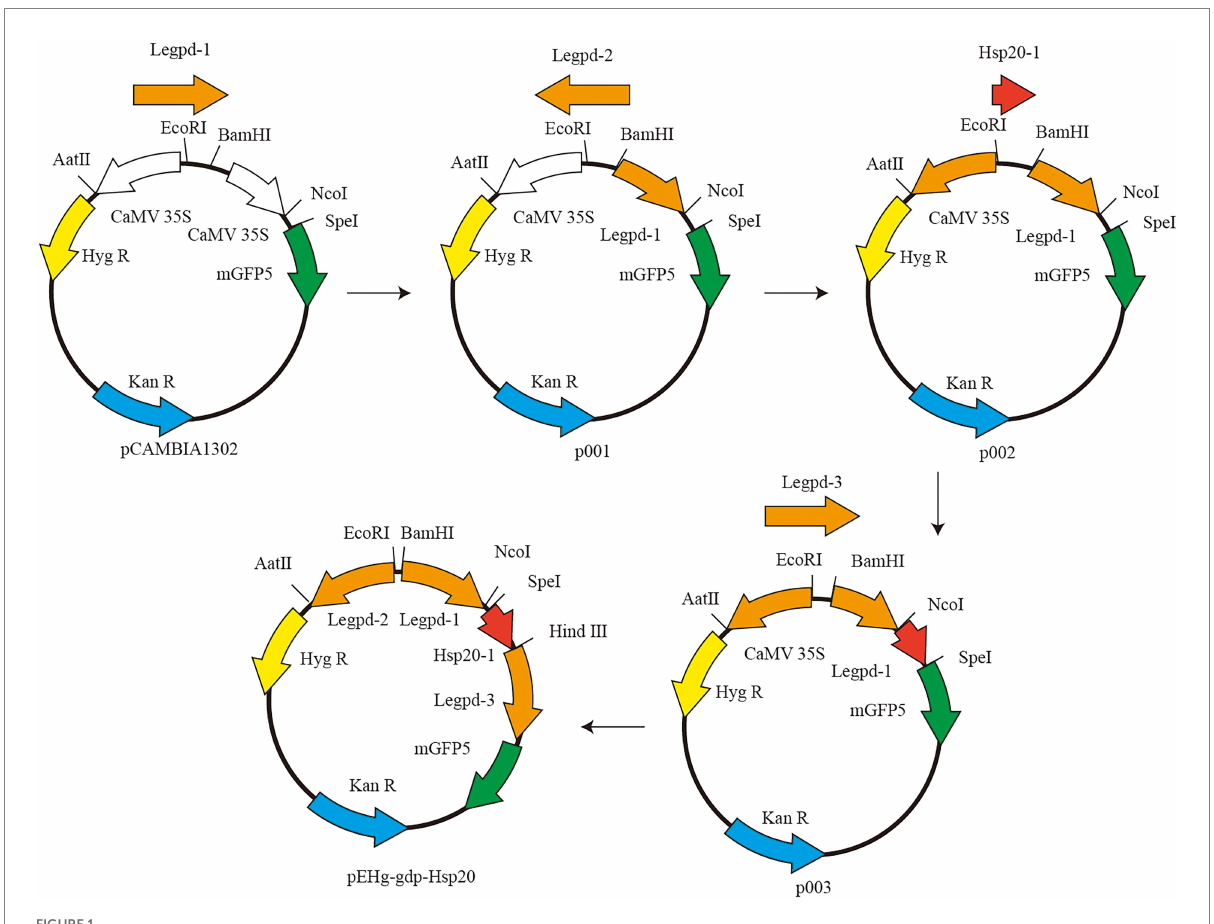
FIGURE 1 The schematic diagram of plasmid pEHg-gdp-